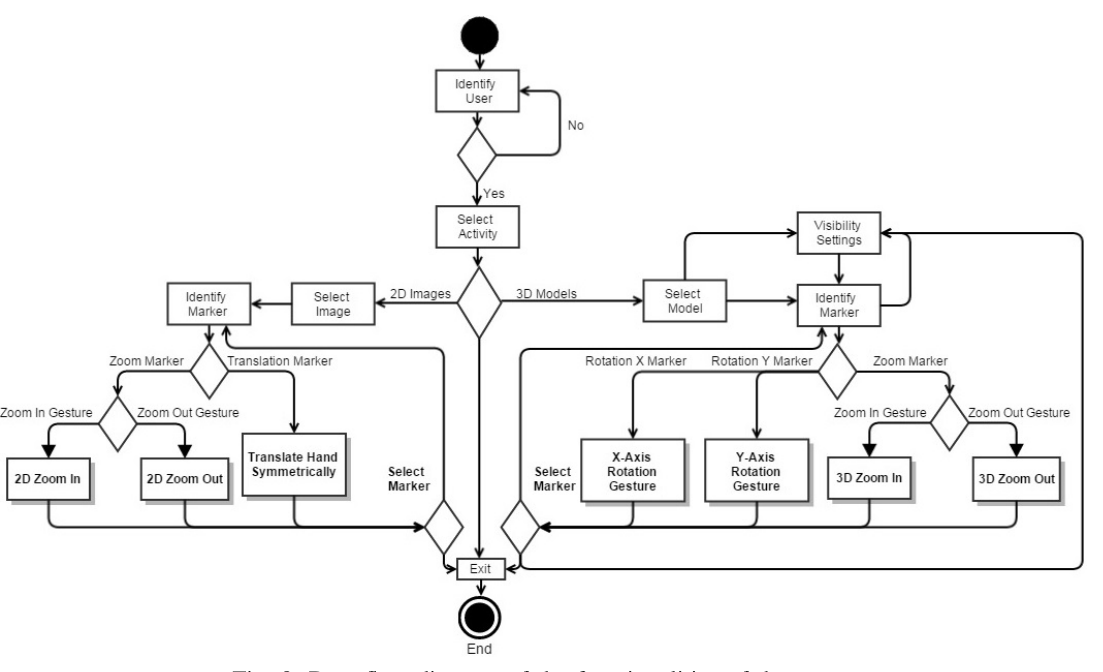
Fig. 8: Data flow diagram of the functionalities of the system.